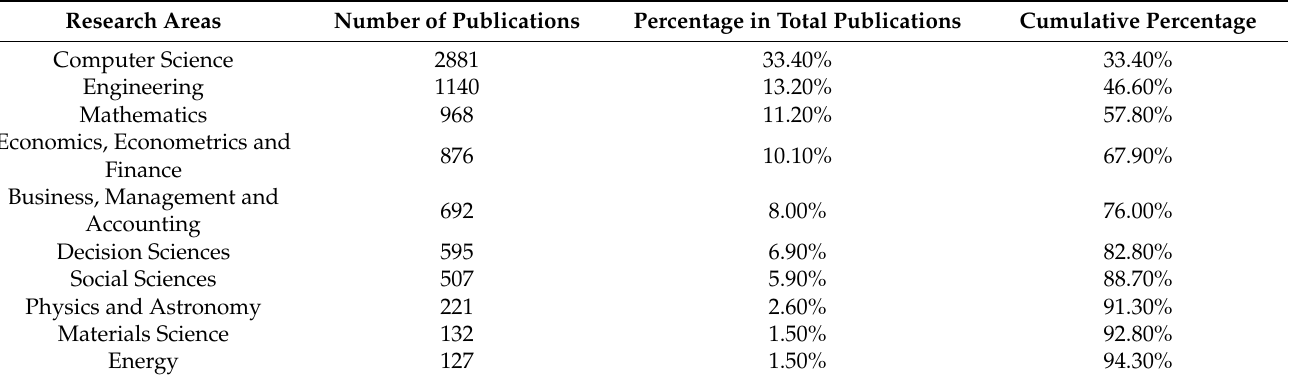
Table 3. Main research areas of Bitcoin studies.